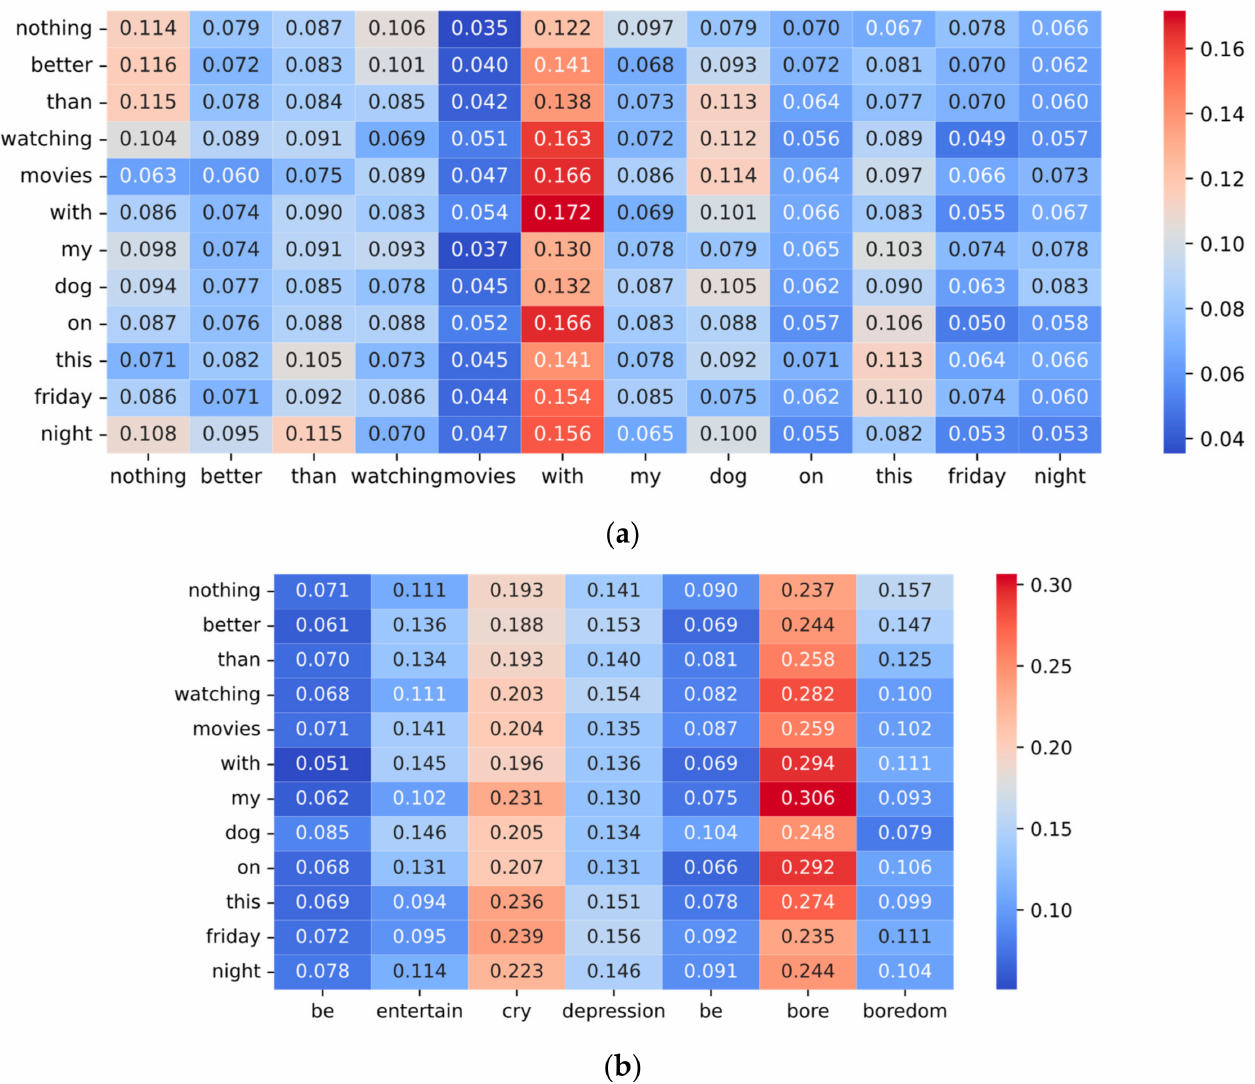
Figure 4. Visualization of the weight scores of the adaptive incongruity extraction module and incongruity cross-attention module: ( a ) Text incongruity attention scores; ( b )Text and knowledge incongruity cross-attention